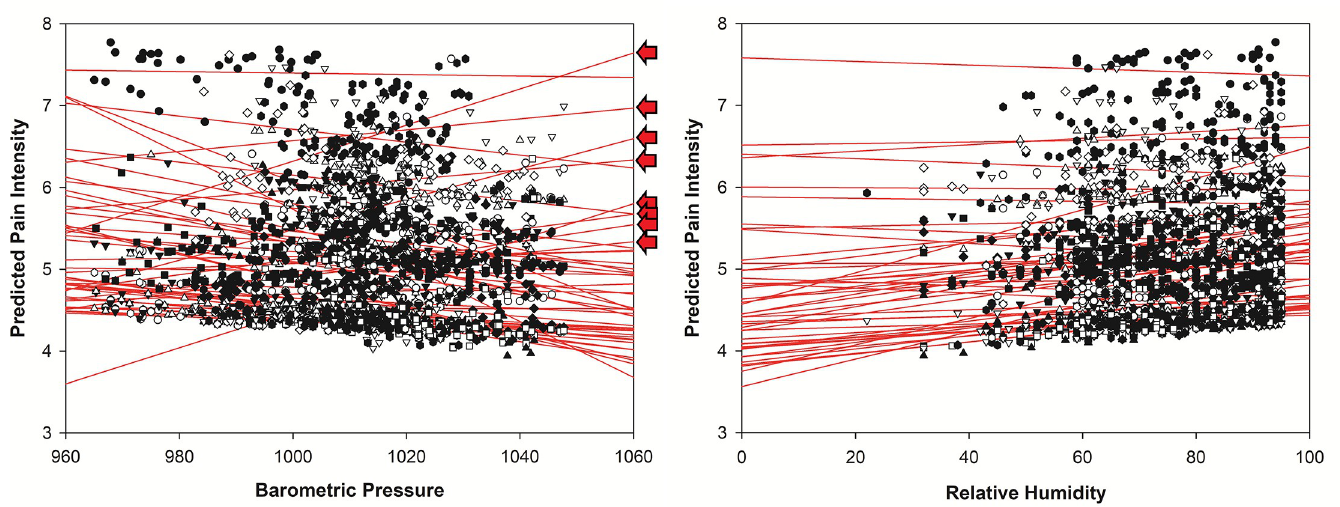
Fig 1. The relation between pain intensity, barometric pressure and relative humidity. Predicted pain intensity was measured on a Numeric Rating Scale from 0–10. Barometric pressure in millibar, relative humidity in percentage. Arrows depict patients (n = 8) with an opposite response in pain reports compared to the majority of the patients (n = 40). Increased barometric pressure was the only weather parameter that significantly affected emotional measures. However, similarly to the pain data, the parameter estimates were small (stress: B = .007, t = 3.97; Tension: B = .003, t = 2.7, both p-values < .005), and increased barometric pressure were associated with elevated negative emotions. The emotional measures of stress and tension varied significantly within patients over the measurement period (Stress: B = .00041, 95% CI (B) = .00026–00067, Wald Z = 4.03, p < .001; Tension B = .00007, 95% CI (B) = .00004–0001, Wald Z = 3.17, p = .002).